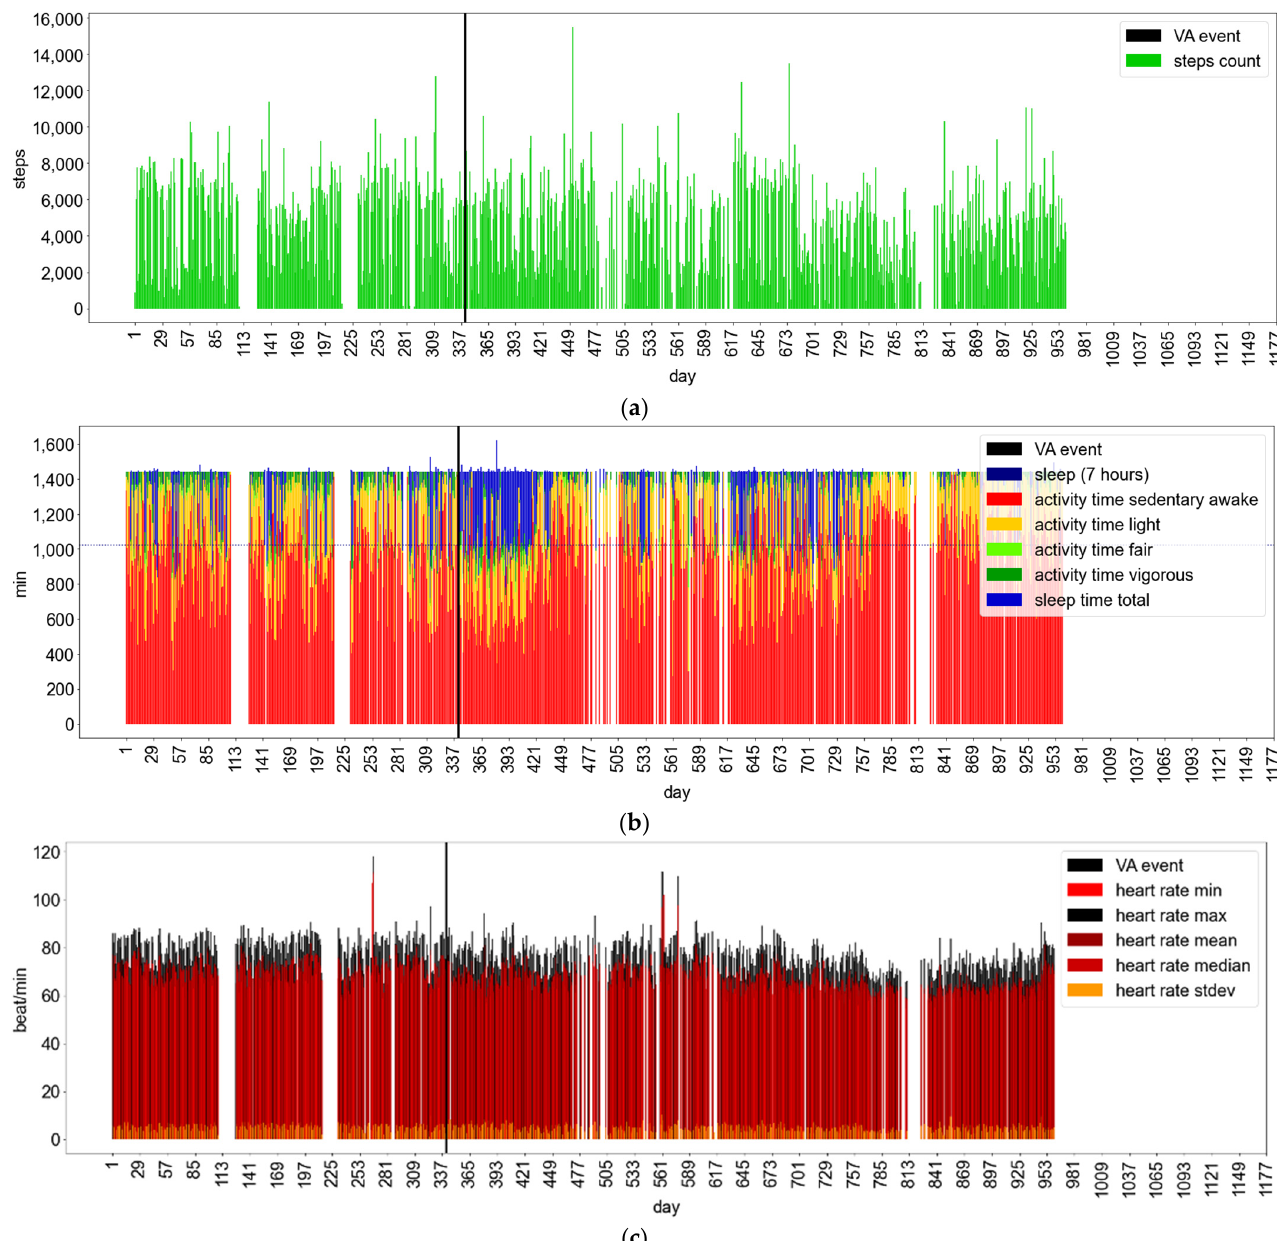
Figure A2. Daily life behaviors (bars) and VA events (strokes) observed in the Fitbit monitoring time interval for Patient 4; ( a ) steps; ( b ) physical activity—sedentary awake includes non-measured and measured-as-sedentary durations excluding measured sleep—and sleep duration; ( c ) heart rate. Patient 12 (male, 66-year-old, device type CRT-D) was monitored over a period of 1147 days (Table A2). He experienced 23 VA events, five of type VT, 12 of type VT1, and six of type VF-VT (Table A1) over a period of 1034 days (Table A2). He is also a compliant